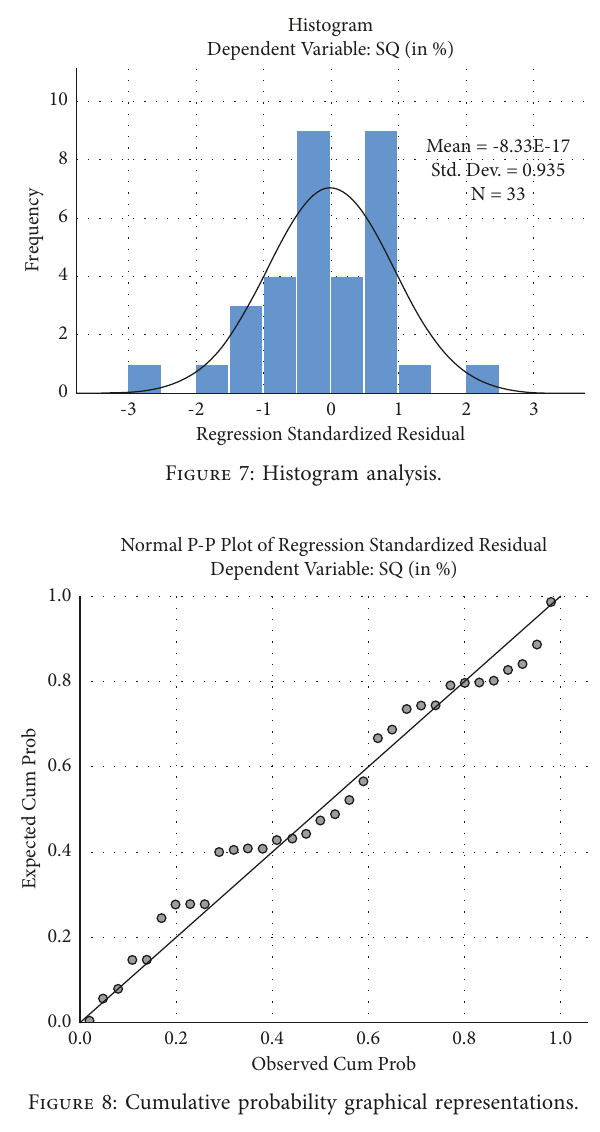
Figure 8: Cumulative probability graphical